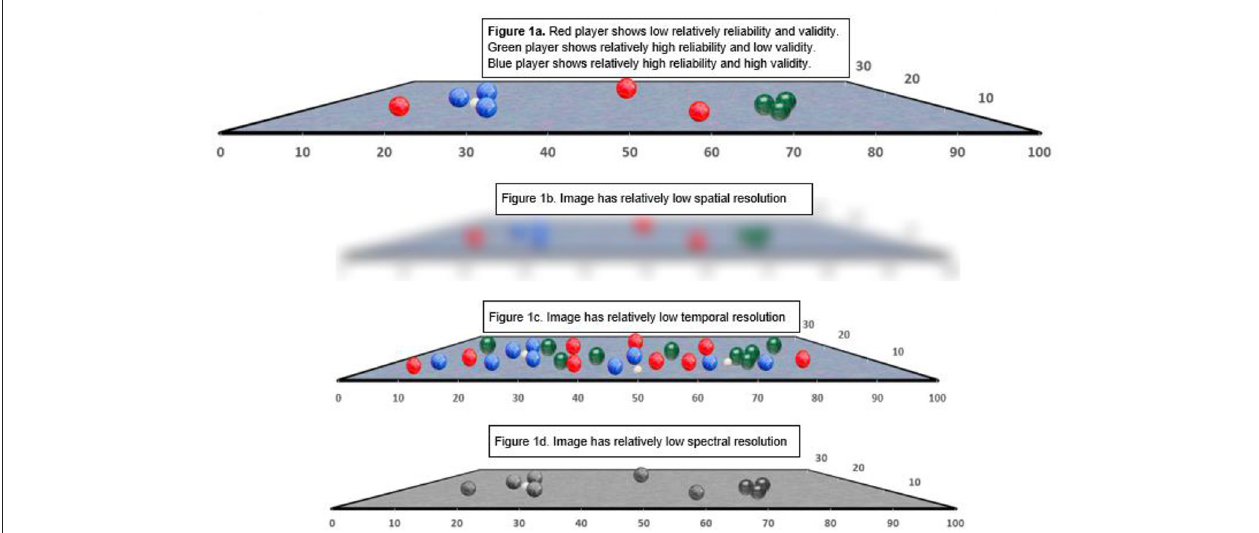
FIGURE 1 | Bocci ball analogy to demonstrate reliability, validity, and the importance of resolution. (A) Red player shows relatively low reliability, and validity. Green player shows relatively high reliability and low validity. Blue player shows relatively high reliability and high validity. (B) Image has relatively low spatial resolution. (C) Image has relatively low temporal resolution. (D) Image has relatively low spectral